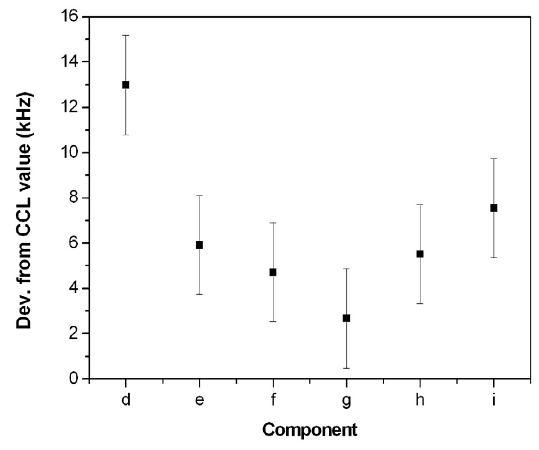
Fig. 4. Frequencies of d, e, f, g, h and i components of the 633 nm laser measured by a femtosecond comb at CEM, printed as differences from MeP values. All values in kHz.